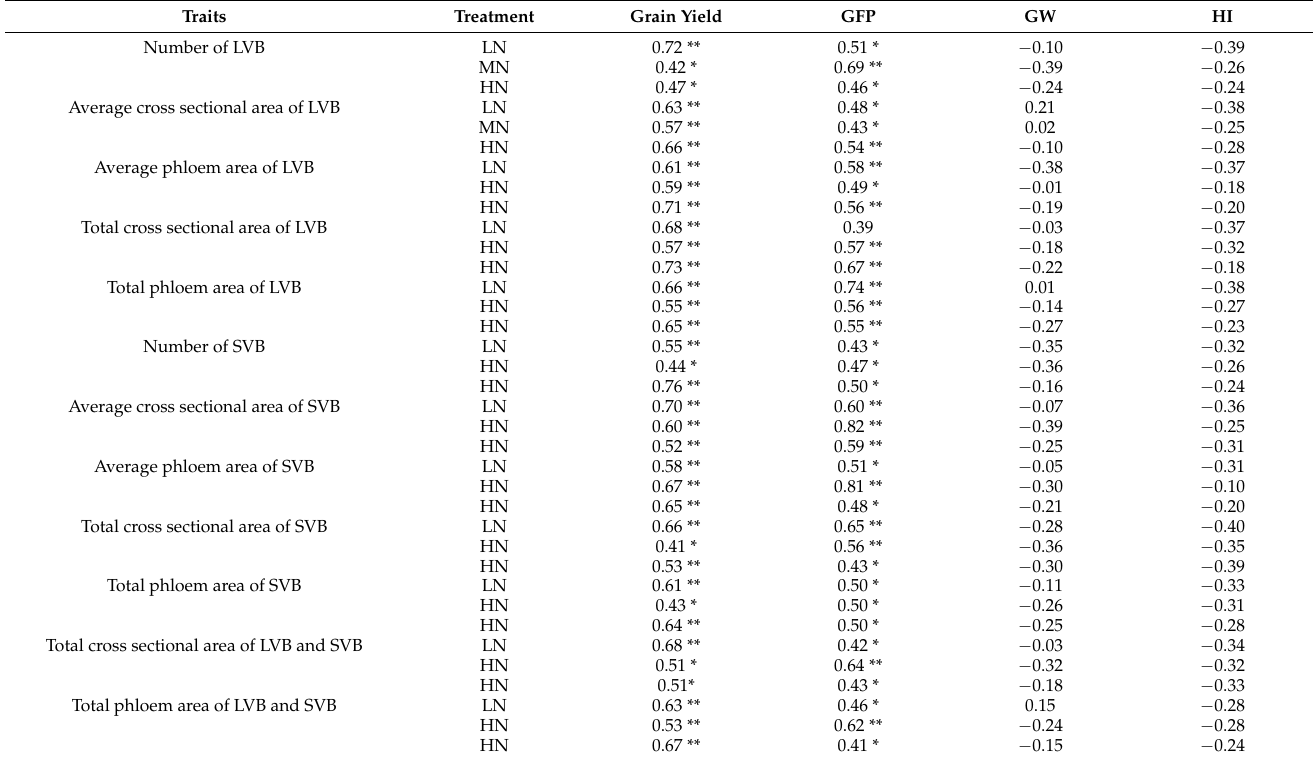
Table 2. Correlations of vascular bundle traits of basal internode with yield-related traits ( n = 24). Traits Treatment Grain Yield GFP GW Number of